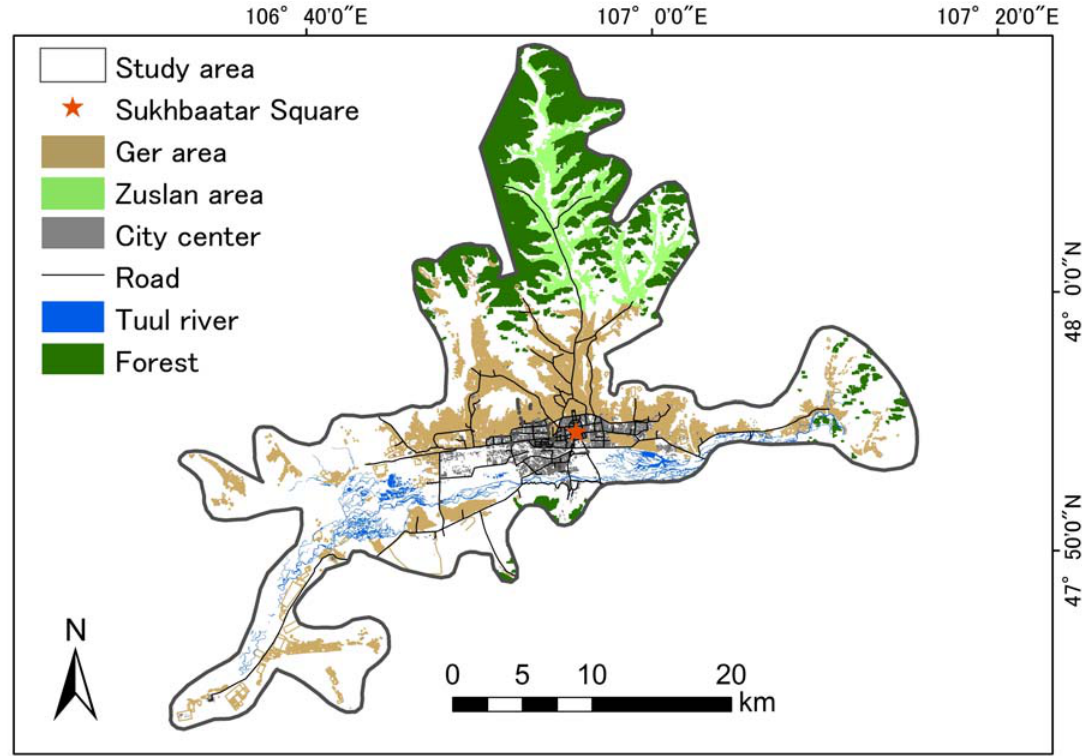
Figure 2. Overview of the study